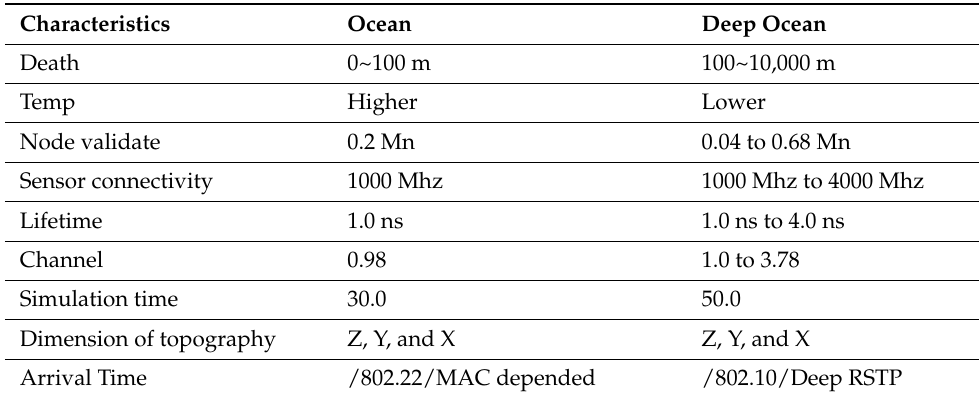
Table 2. Characteristics of